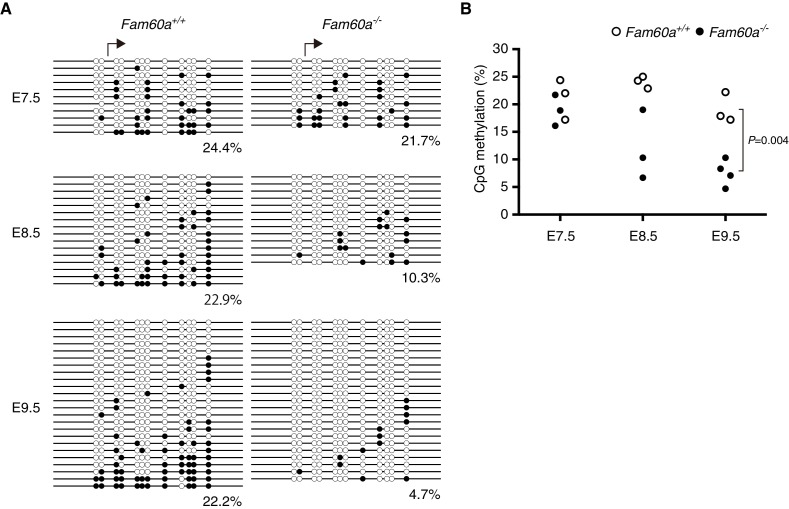
Methylation status of the Adhfe1 promoter during development of WT and Fam60a–/– mouse embryos.(A) Methylation pattern at the Adhfe1 promoter in representative WT and Fam60a–/– embryos at the indicated developmental stages as revealed by bisulfite sequencing. Closed and open circles indicate methylated and nonmethylated CpG sites, respectively. Arrows indicate the TSS of Adhfe1. (B) Methylation frequency at the Adhfe1 promoter determined as in (A) for three or four individual embryos of each genotype at each developmental stage. The p value was determined with Student’s unpaired t test. See also Figure 7—figure supplement 1 to 3.10.7554/eLife.36435.040Figure 7—source data 1.Numerical data of Figure 7B.10.7554/eLife.36435.041Figure 7—source data 2.Numerical data of Figure 7—figure supplement 2.